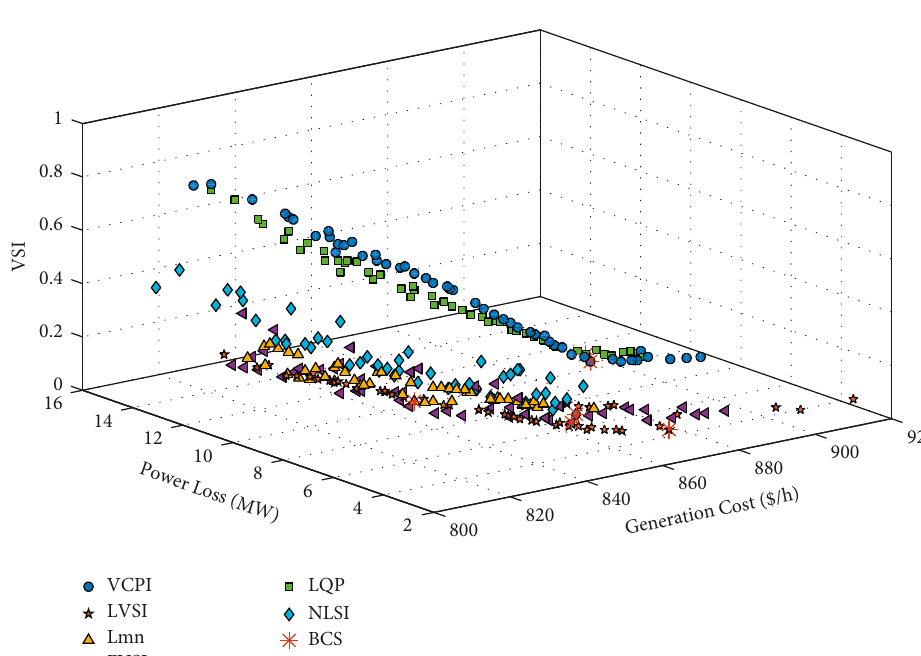
Figure 9: SC-2 Pareto-optimal solutions for the six case